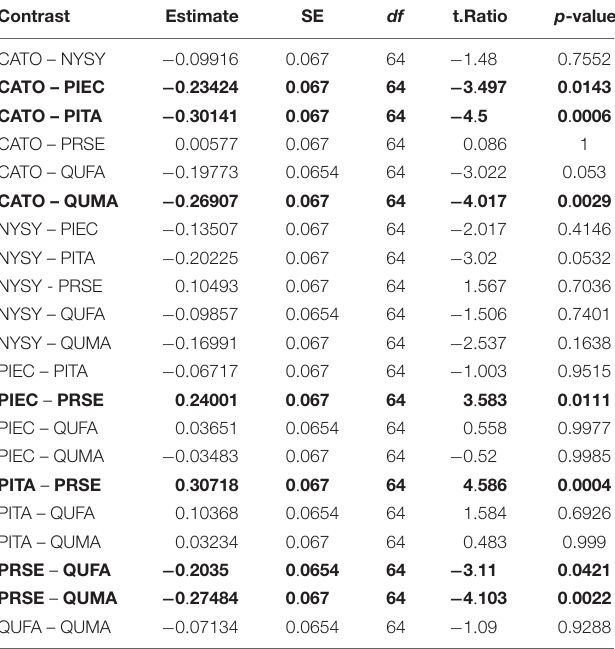
as a pyrophyte (but see Varner et al. in this special issue on its